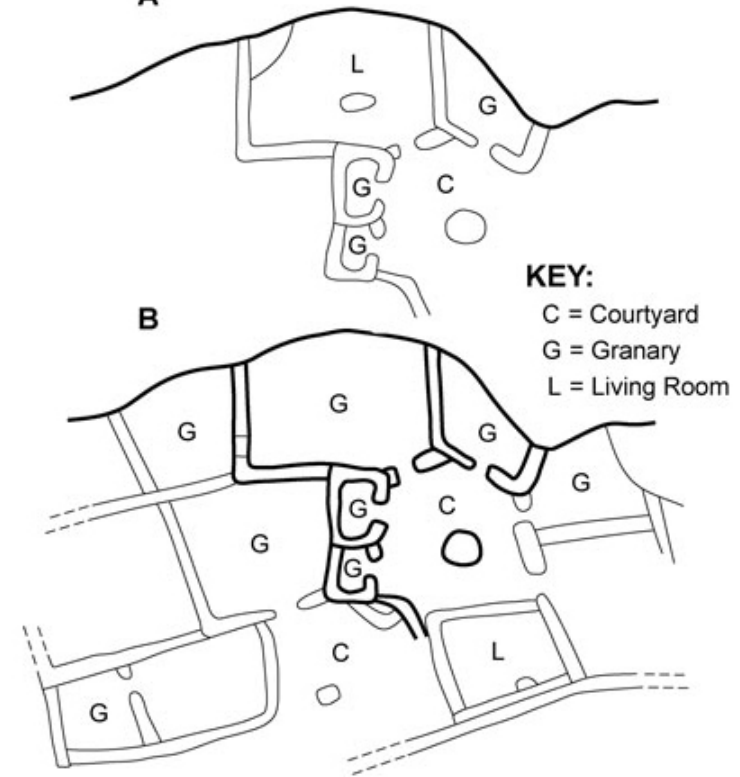
Fig. 2 . Room Cluster 2 at Kiet Siel, Tsegi Canyon, northeastern Arizona: (A) in A.D. 1271 with three fairly small granaries, and (B) in A.D. 1276 with eight granaries, note the living room turned into a granary. After Dean 2006, Figure